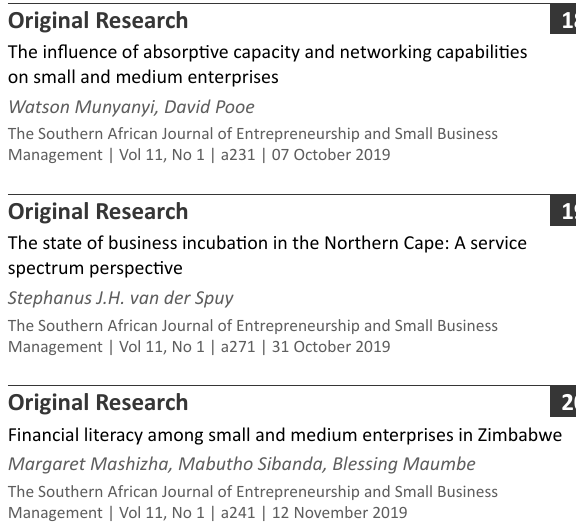
The structural validity of the innovative work behaviour questionnaire: Comparing competing factorial